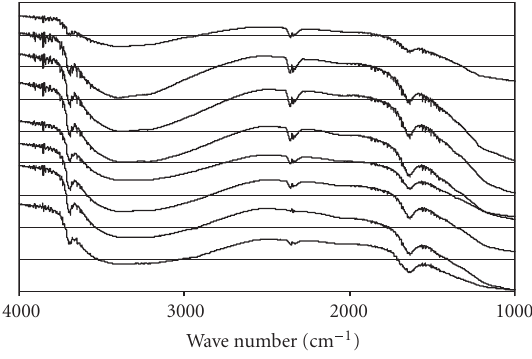
Figure 8: FTIR spectra for P25 photocatalyst samples. From bot- tom to top: untreated P25, P25/700 ◦ C, P25/750 ◦ C, P25/800 ◦ C, P25/850 ◦ C, P25/900 ◦ C, P25/950 ◦ C, P25/1000 ◦ C.